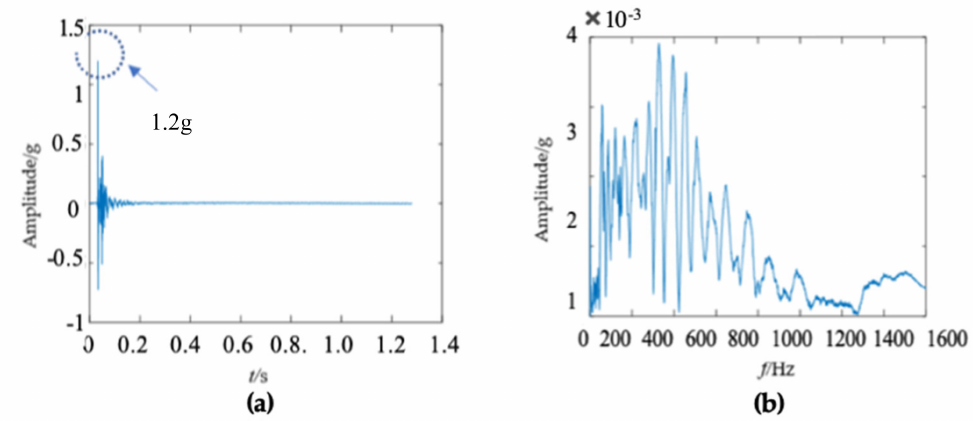
Figure 11. Vibration response signal and frequency spectrum of the wooden utility pole labeled as 244984: ( a ) the vibration response in the time domain and ( b ) the frequency